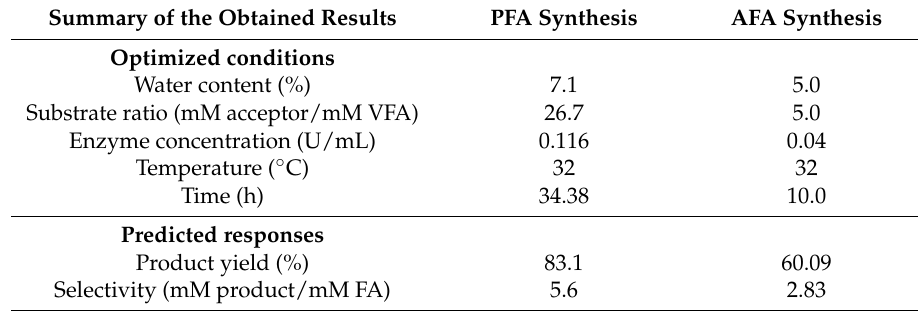
Table 4. Overview of optimum conditions and the obtained results of the present study for both products